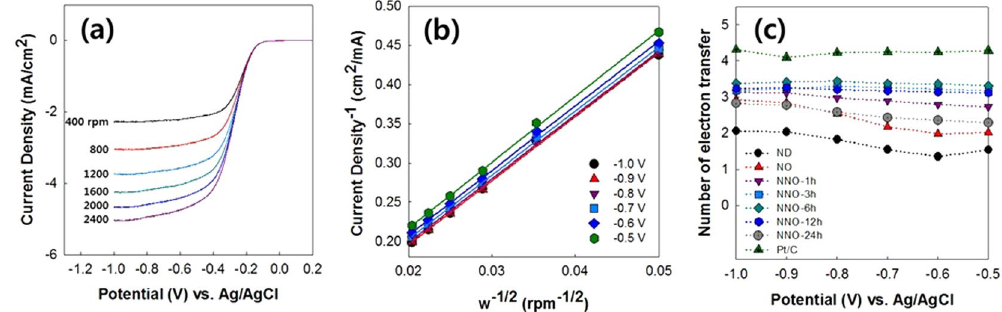
Figure 7. ( a ) LSV curves of NNO-6h examined at various rotation speeds from 400 to 2400 rpm, ( b ) Koutecky- Levich plot obtained from the LSV curves of NNO-6h, and ( c ) the number of electrons transferred for ND, NO,